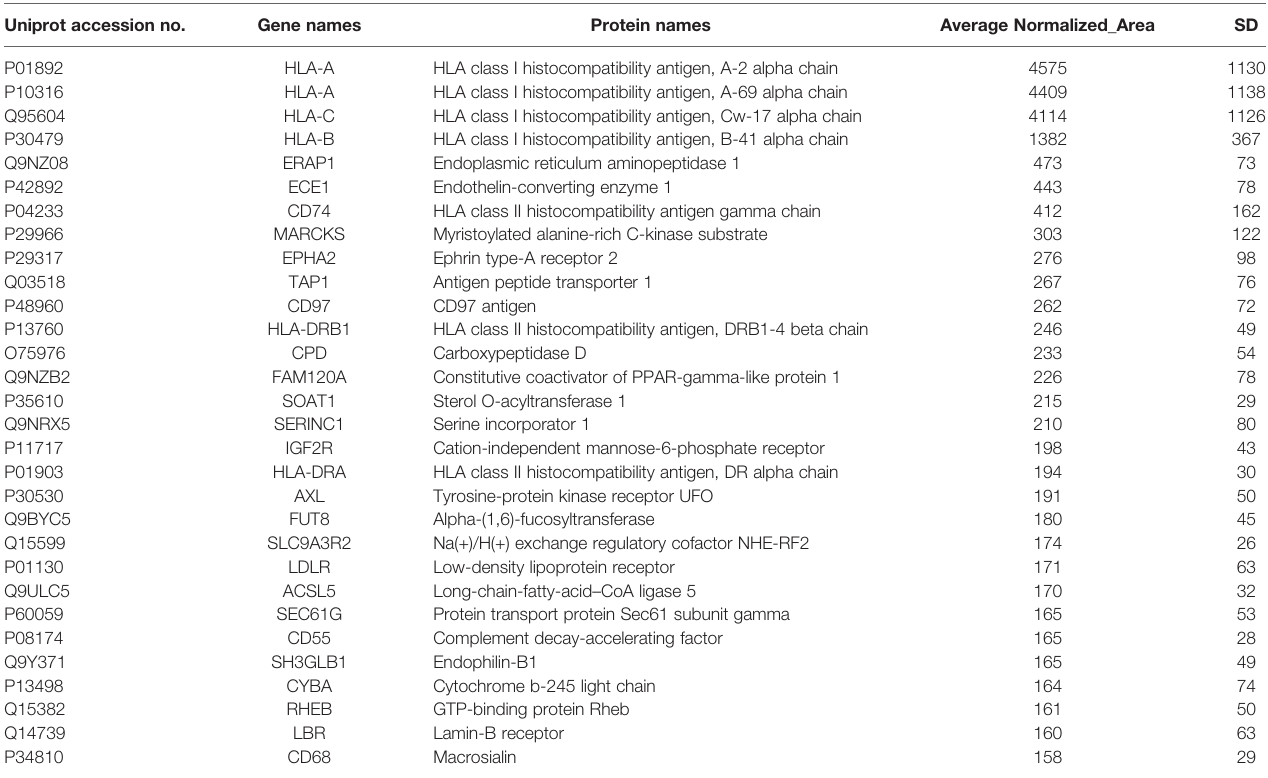
TABLE 2 | Selected membrane associated proteins speci fi cally identi fi ed in MDA-MB-231 compared to MCF-10A cells. Uniprot accession